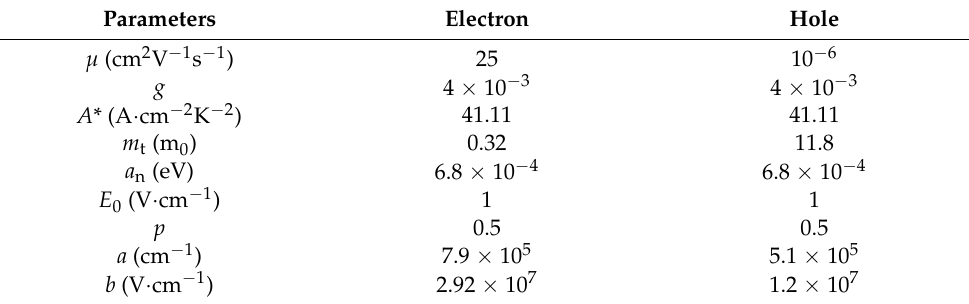
Figure 1. Extraction results of simulation parameters ( a , b ). Forward and reverse characteristics of the device with both the experimental results from reference [13] and the simulated results: ( a ) for ‐ ward characteristics and ( b ) reverse characteristics. Table 1. Material simulation parameter table.